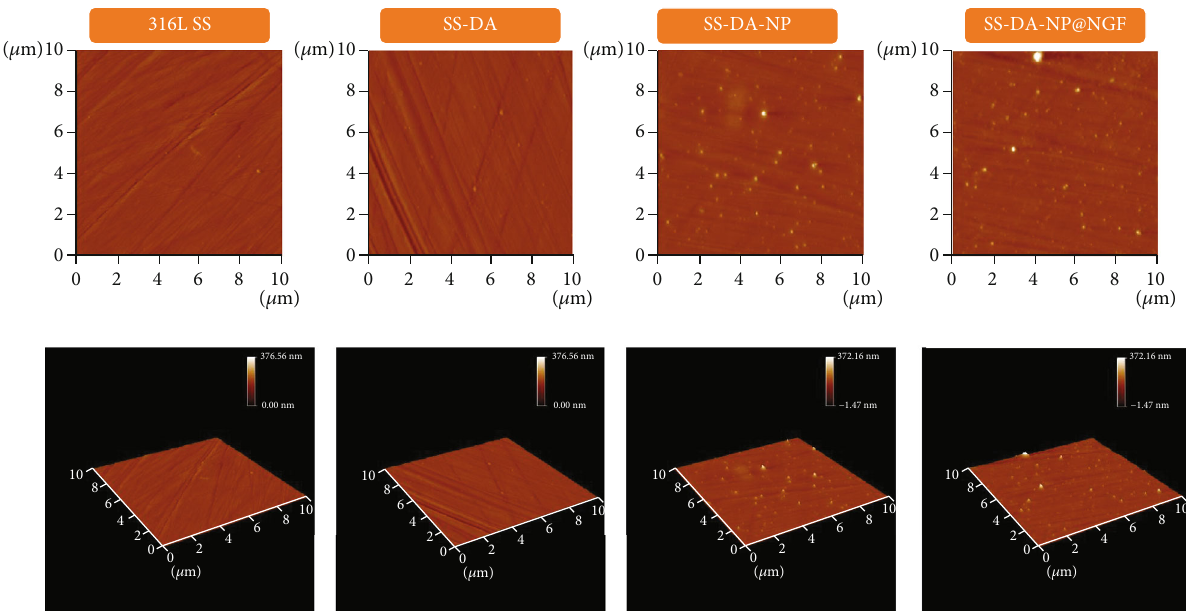
Figure 2: AFM images of CHS/Hep and CHS/Hep@NGF NP-modi fi ed